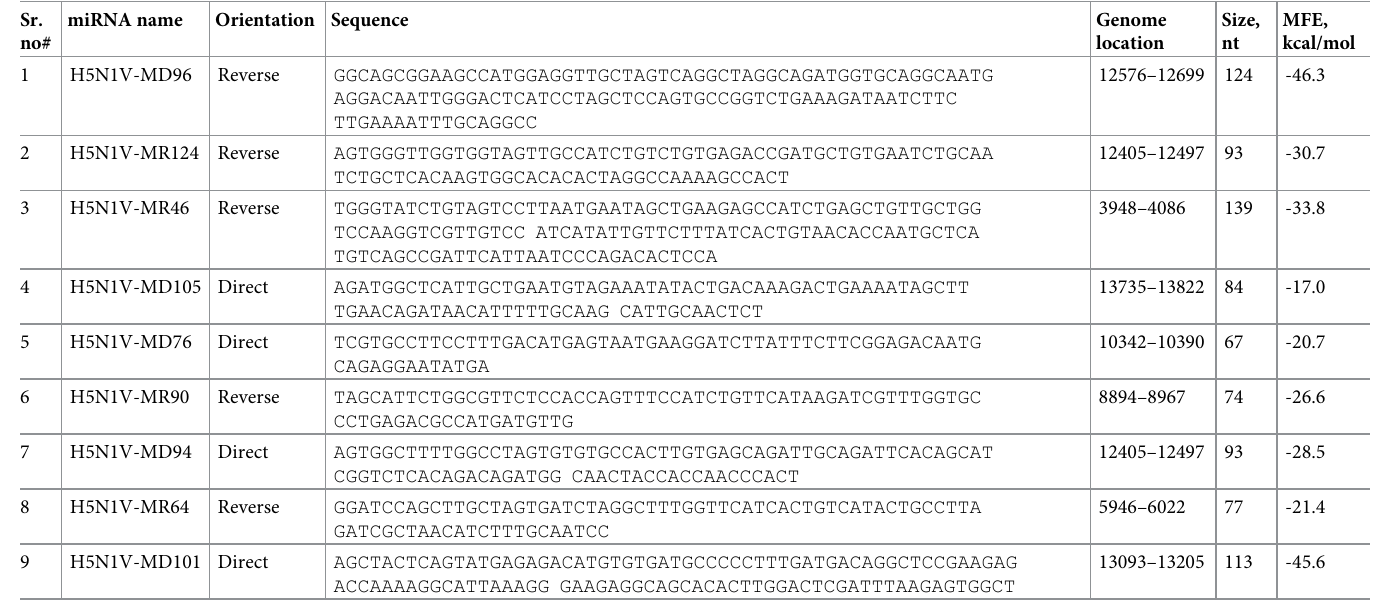
Table 1. pre-miRNA obtained from VMir and further validated using imiCRNA and RNAstructure. Sr. miRNA no#